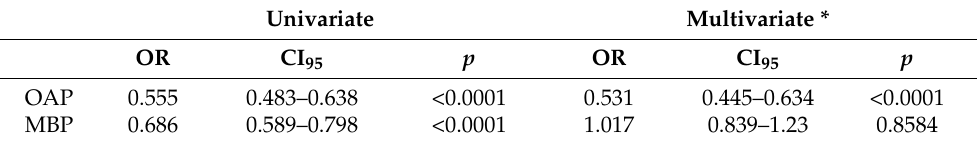
Table 5. Effect of OAP and MBP on overall